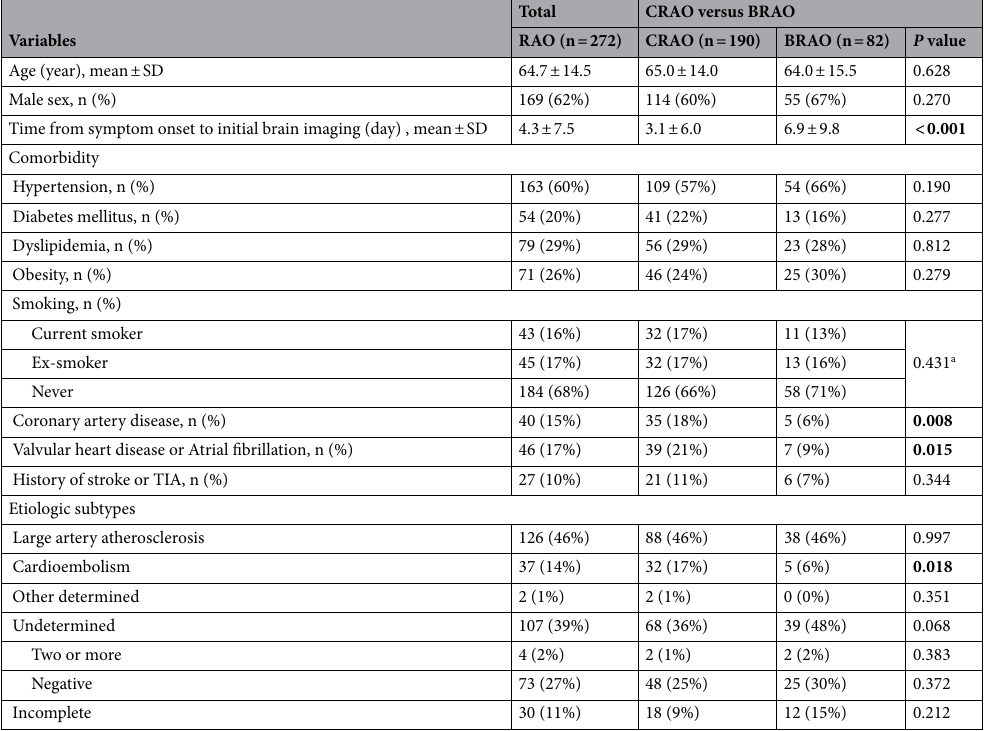
Table 1. Baseline clinical characteristics of patients with central retinal artery occlusion (CRAO) and patients with branch retinal artery occlusion (BRAO). Data are presented as number (%) or mean ± standard deviation. P < 0.05 was deemed to indicate clinical significance, values in boldface are statistically significant. TIA = transient ischemic attack. a Linear-by-linear association.